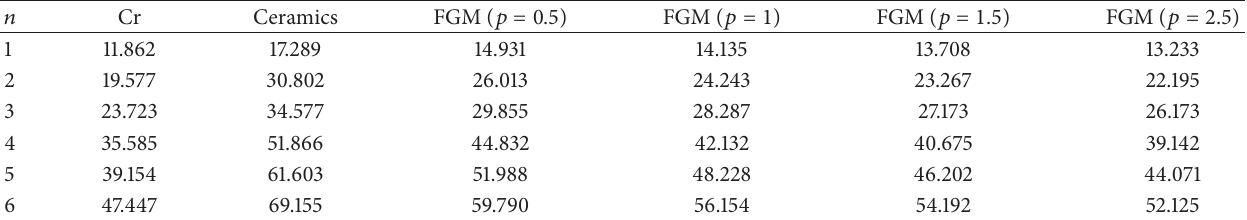
Table 1: Products of thickness and cutoff frequencies of the Lamb waves propagating in the homogenous plate and the FGM plate 𝜔 𝑛 ℎ (MHz ⋅